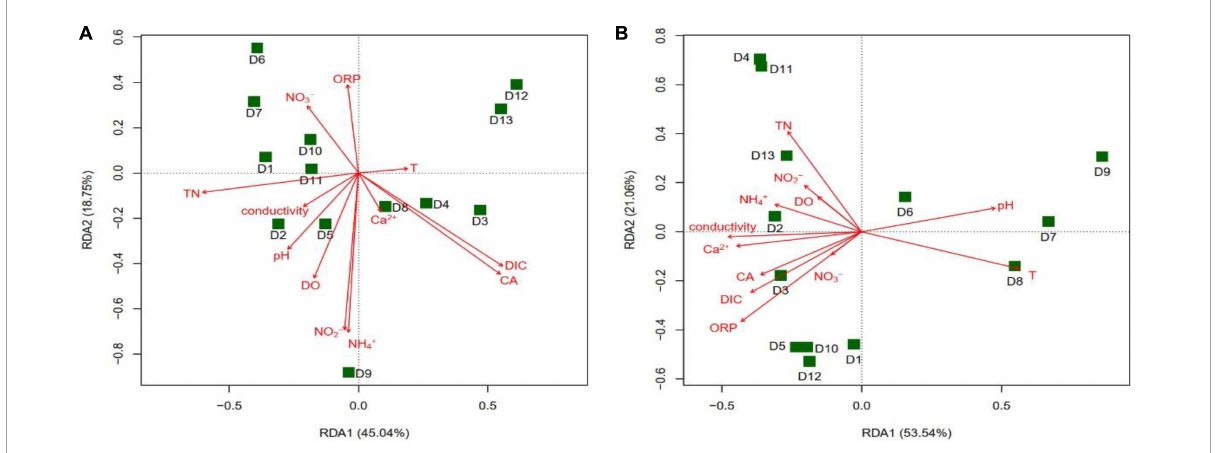
FIGURE8 Redundancy analysis (RDA) of the cbbL gene-containing CO 2 -fixing bacterial community structures with environmental factors in the Huixian karst groundwaters. (A) Winter (201801); (B) Summer (201807).